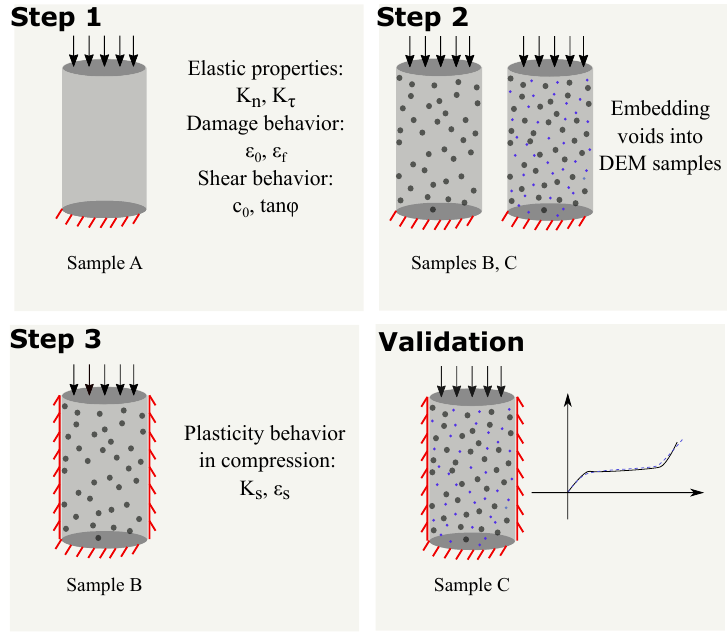
Figure 6. Calibration procedure. Step 1: Calibration of contact parameters using the uniaxial response of sample A. Step 2: Generating composite samples by embedding spherical voids representing the air voids and the expanded polystyrene (EPS) inclusions into the numerical DEM model for sample A. The voids are embedded into the DEM specimen by removing the DEM particles lying within the spherical region defined by the void location. Step 3: Calibration of plasticity parameters of the DEM model to match the compaction behavior of sample B under confined compression. Validation: The stress–strain response obtained by the DEM simulation of sample C under confined conditions is compared with laboratory results for sample